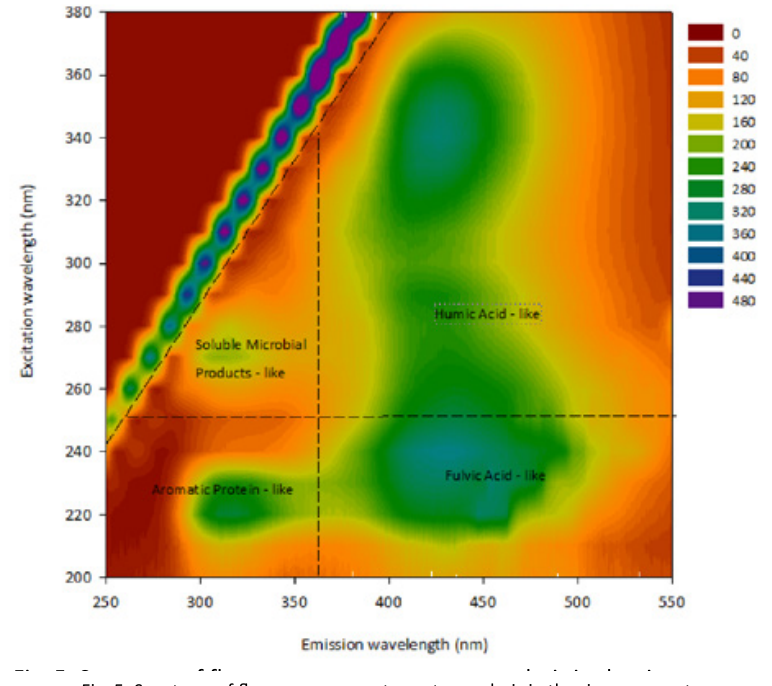
Fig. 5: Spectrum of fluorescence spectrometer analysis in the river segment